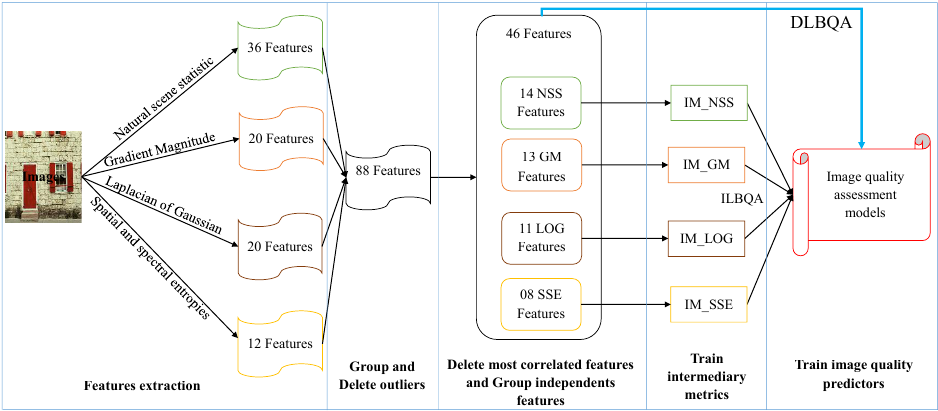
Figure 2. Design of prediction models for objective no-reference IQA